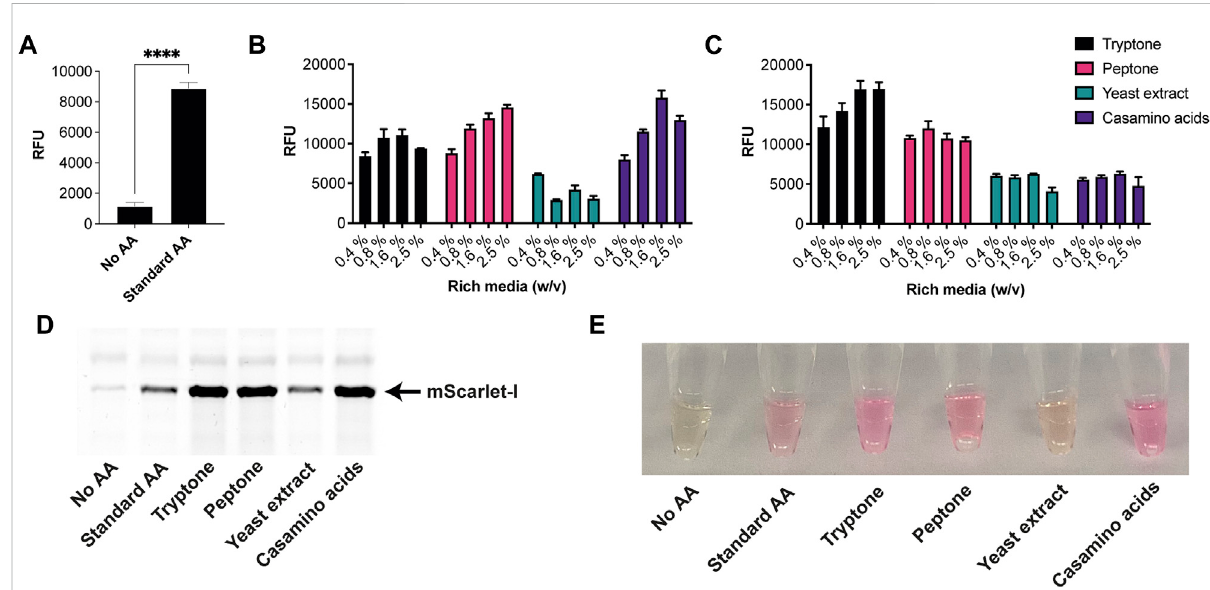
FIGURE 2 S. venezuelae CFE activity with AA substitutes. (A) End-point fl uorescence measurements of S. venezuelae CFE control reactions with no AAs and 1 mM of commercial standard (Sigma). (B) End-point fl uorescence measurements of S. venezuelae CFE reactions with rich media commercial batchA,seeSupplementaryTableS1. (C) End-point fl uorescencemeasurementsof S.venezuelae TX-TLreactionswithrichmediacommercialbatch B, see Supplementary Table S1. (D) In-gel fl uorescence stain of C-terminal tetracysteine tagged mScarlet-I. (E) Visual image of mScarlet-I at endpoint. Cell-free reactions were set up as described in the methods and results text. Error bars in standard deviation represent three technical measurements. End-point samples were collected after overnight incubation (16 h) at 30 °